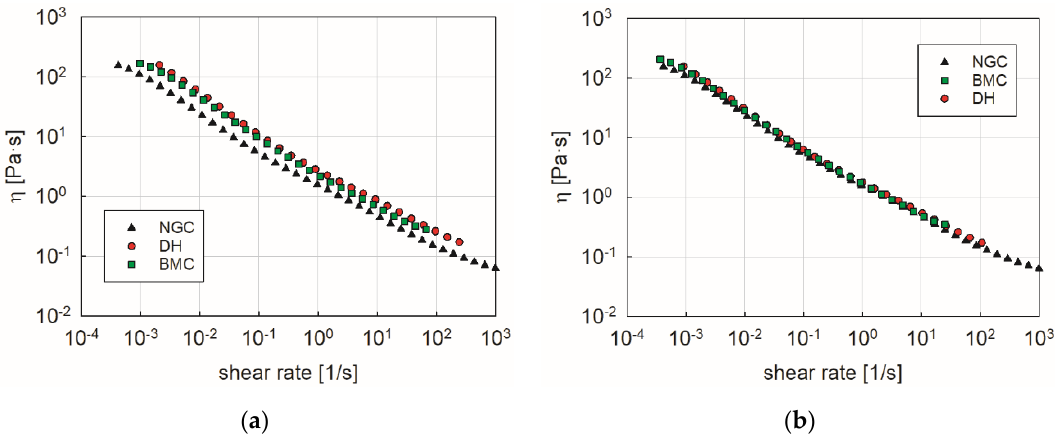
Figure 7. The viscosity of the WBM drilling fluid suspension as a function of shear rate for the NGC and the two complex geometries. ( a ) Results obtained by using the c SS and c SR coefficients provided by Anton Paar; ( b ) Results obtained by using the c SS and c SR coefficients from the Couette analogy.